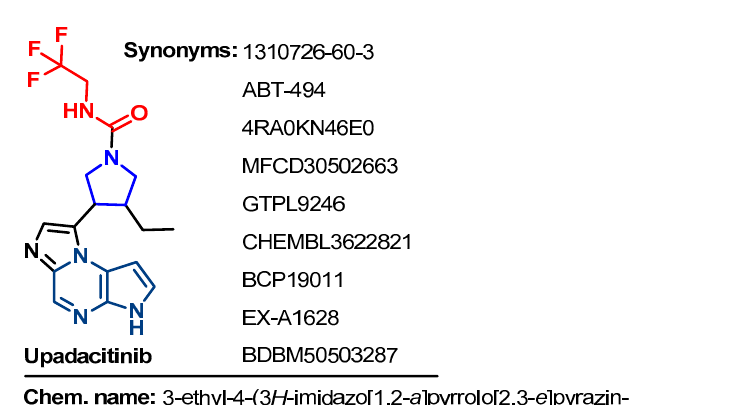
Figure 66. Chemical structure/name/synonyms of upadacitinib.